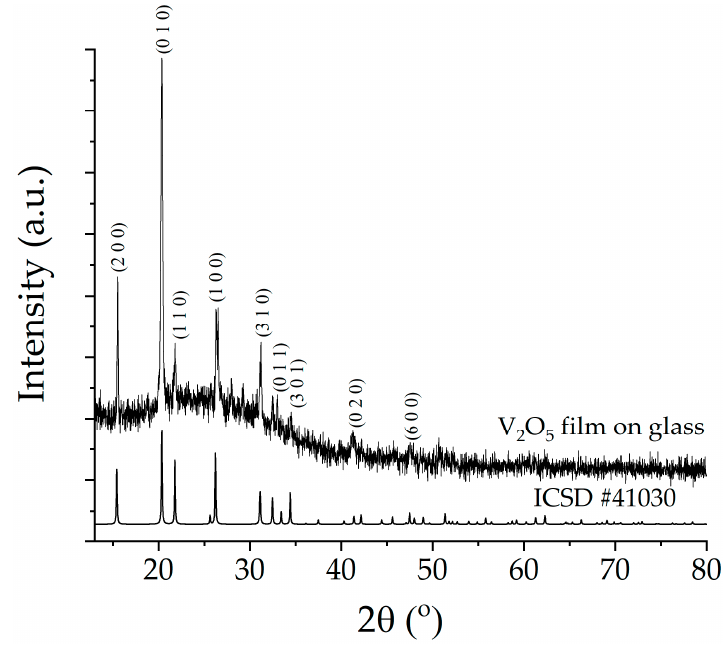
Figure 4. Diffractogram of the obtained V 2 O 5 film on a glass substrate.